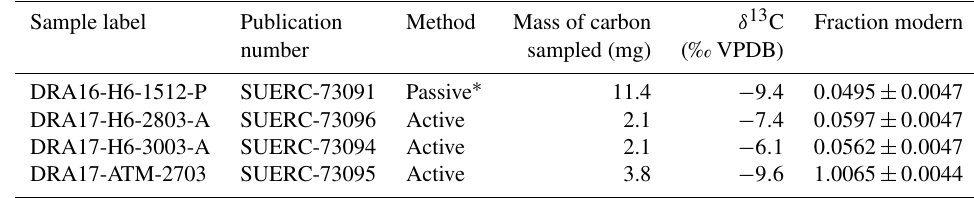
Table 2. Isotopic composition of the CO 2 sampled with the zeolite molecular sieves. Sample label